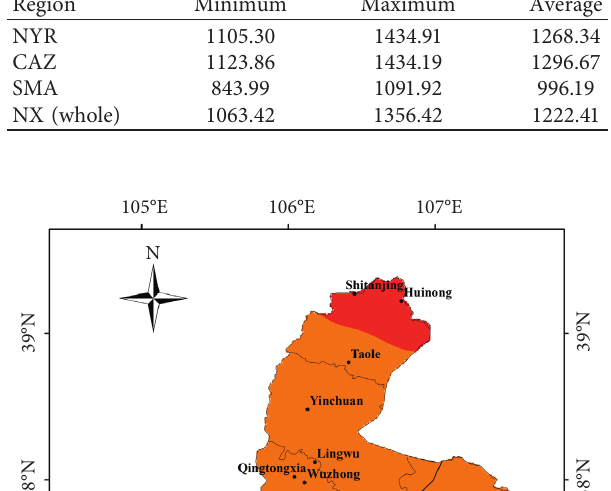
Table 6: Multiyear average statistic value of ET